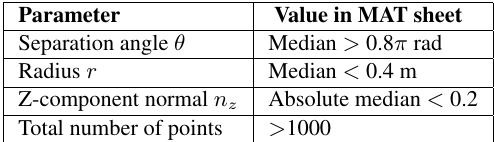
Table 2. Theoretical parameters for filtering MAT sheets